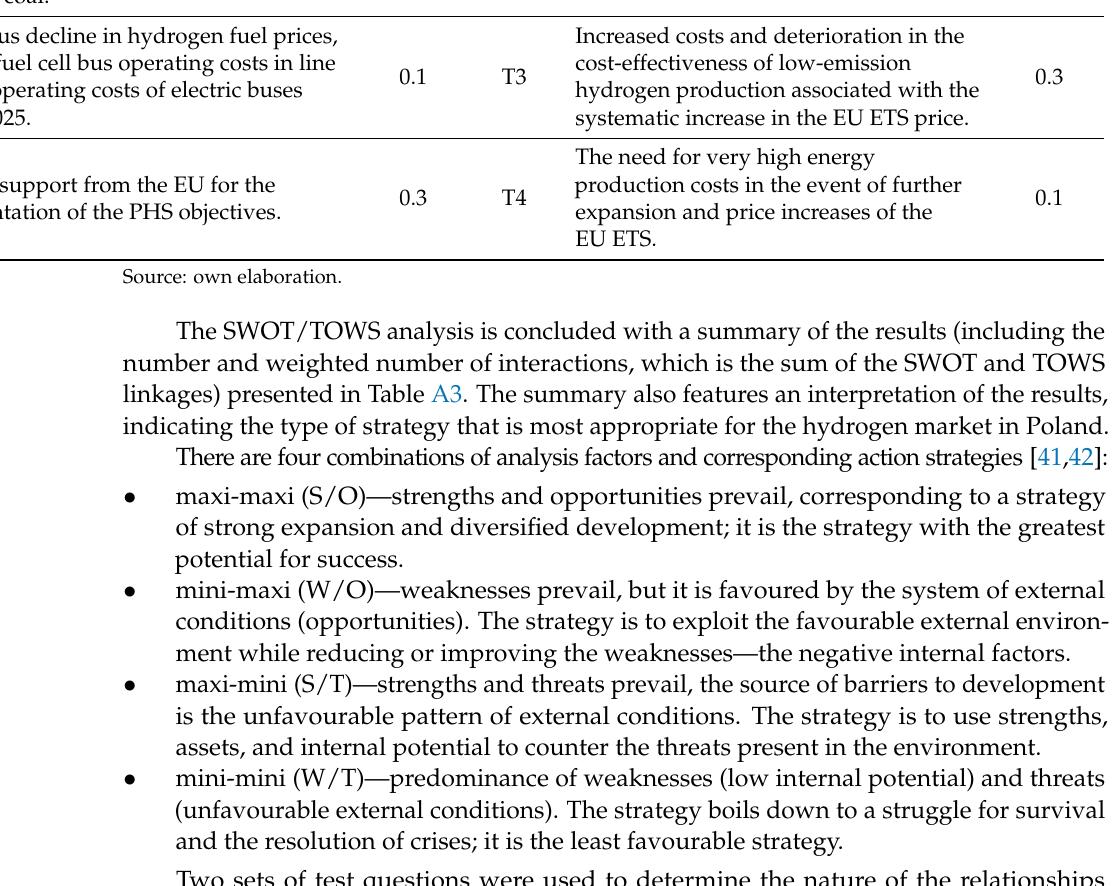
Table 2. Cont. A rapid improvement in the price competitiveness of hydrogen obtained in electrolysers powered by offshore wind farms vis- à -vis hydrogen obtained from O2 fossil sources due to strong price increases for all fossil energy feedstocks, including coal. Continuous decline in hydrogen fuel prices, bringing fuel cell bus operating costs in line with the operating costs of electric buses around 2025. Financial support from the EU for the implementation of the PHS